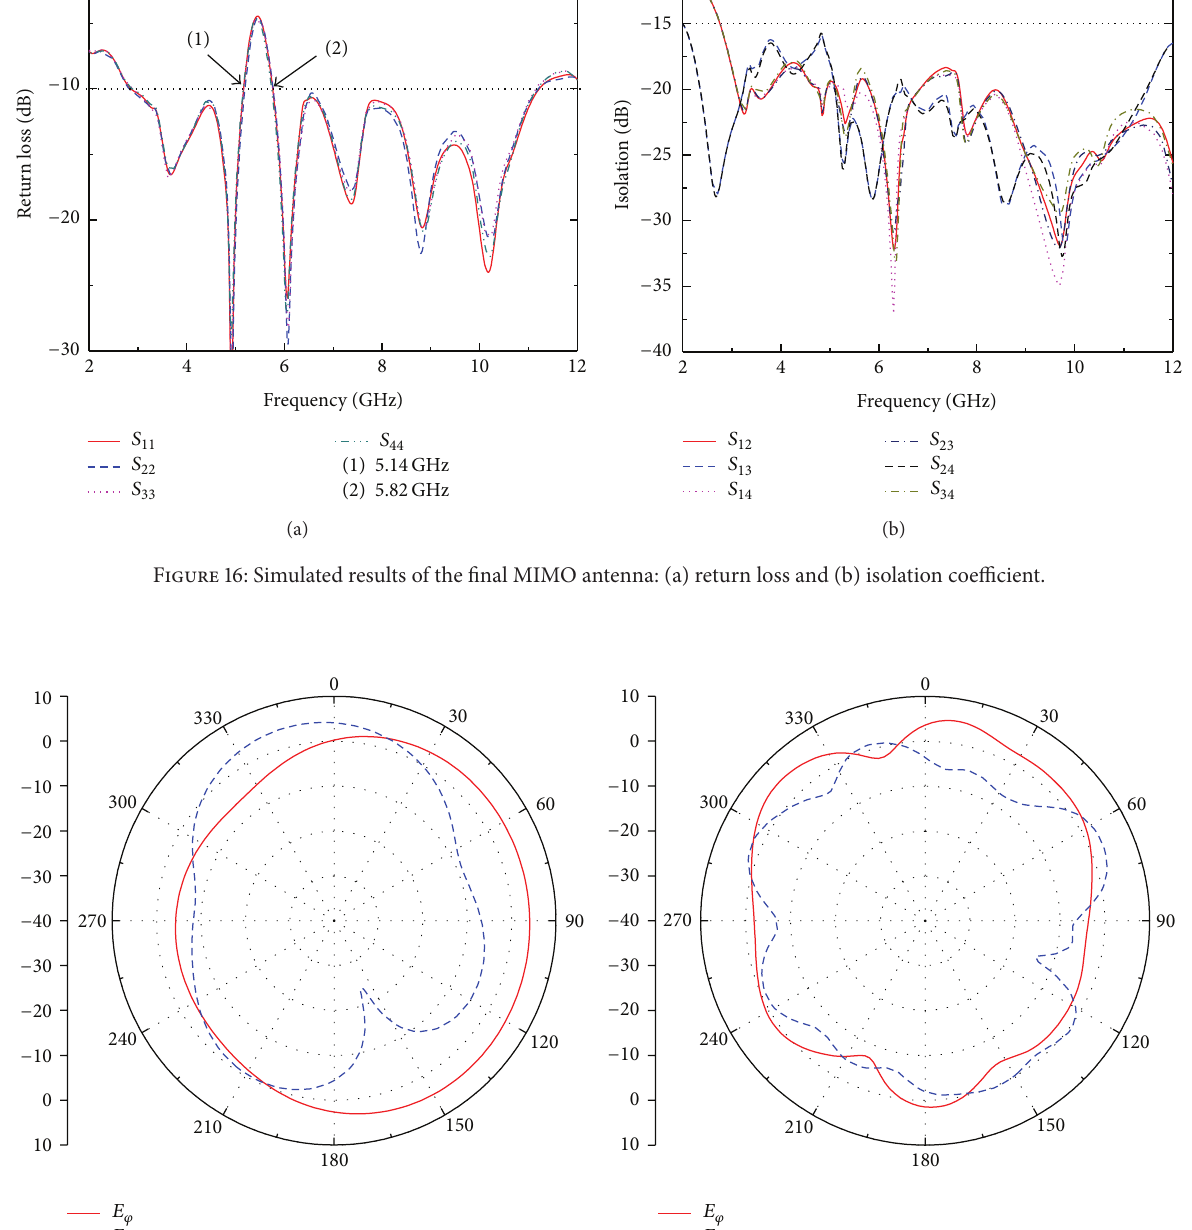
notched band appears in WLAN range (from 5.14